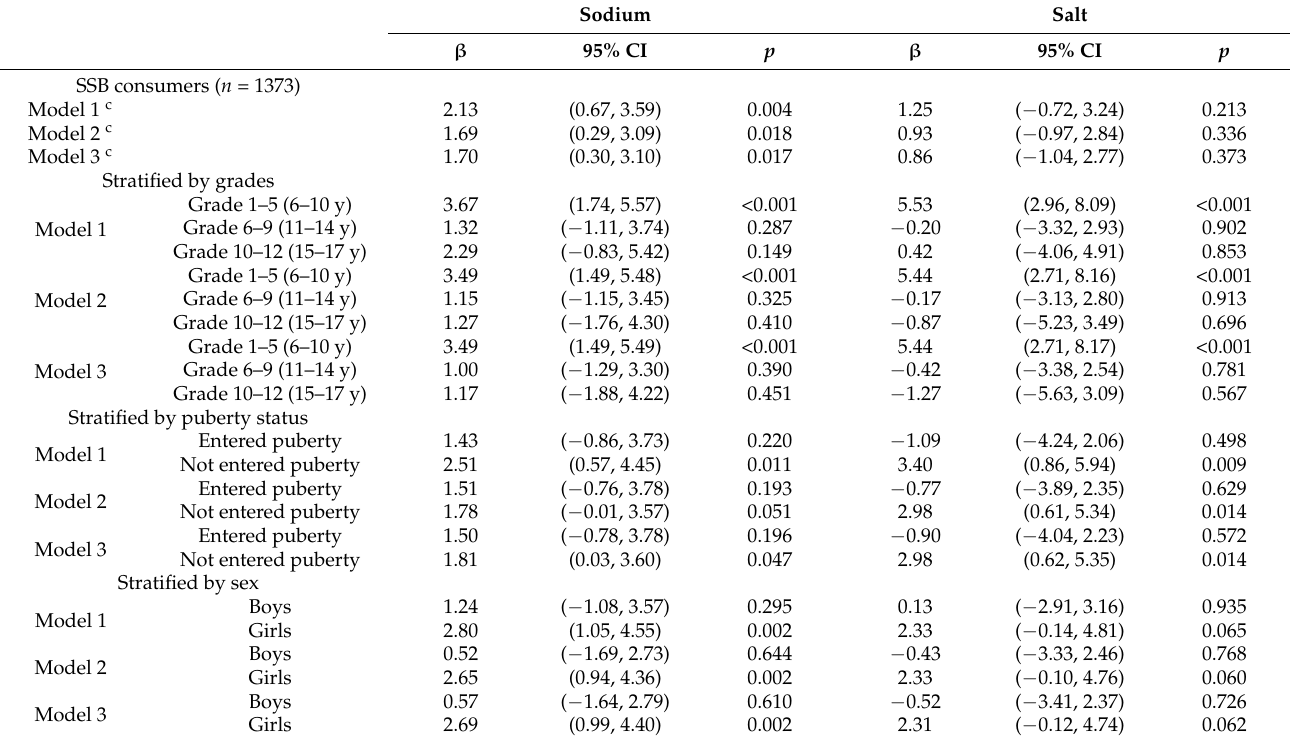
Table 3. Multiple linear regression analysis of SSB consumption (g/d) and dietary sodium intake (390 mg/d)/salt intake (1 g/d) among the SSB consumers a,b